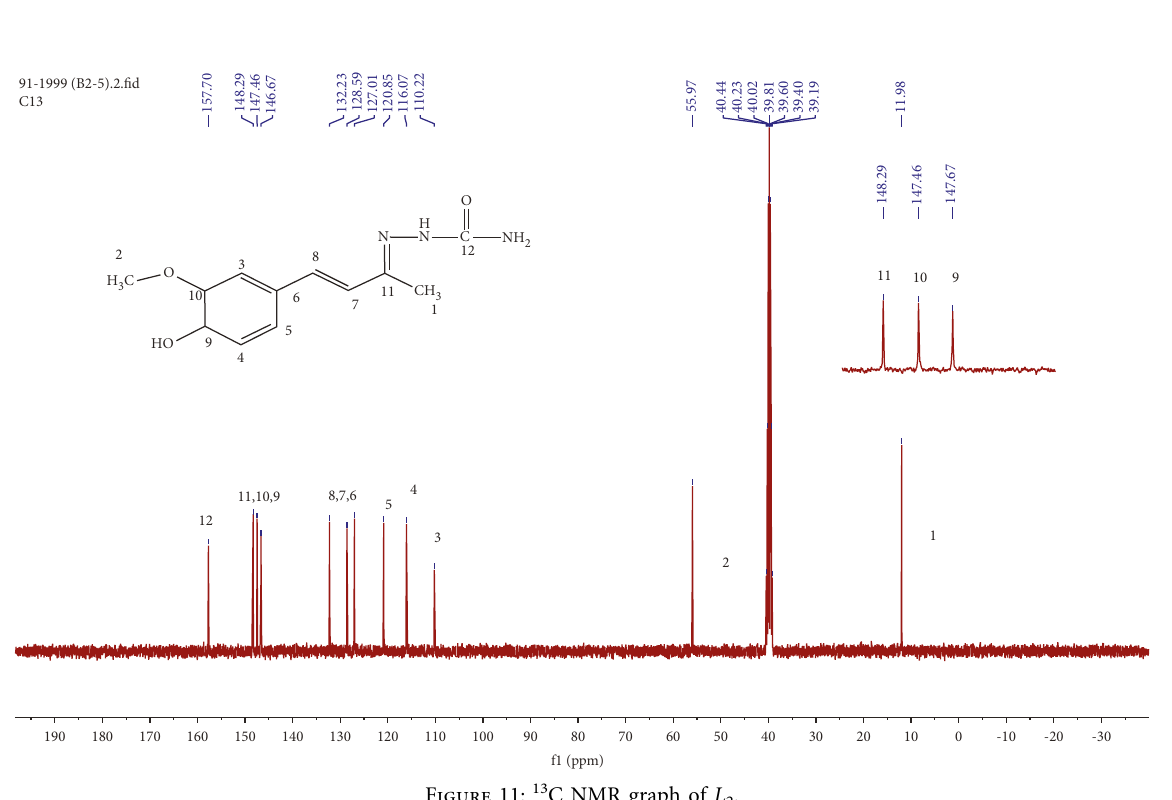
Figure 10: 1 H NMR graph of L